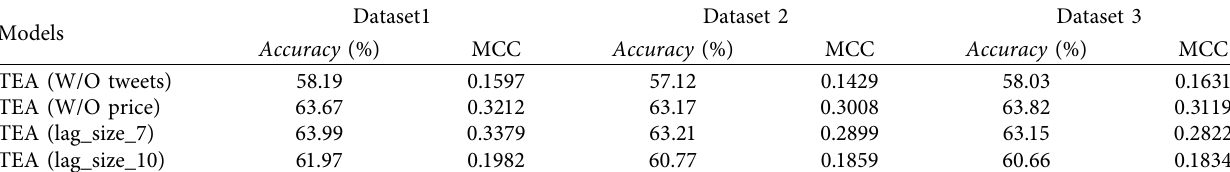
Table 2: Performance of TEA variations in Accuracy and MCC.